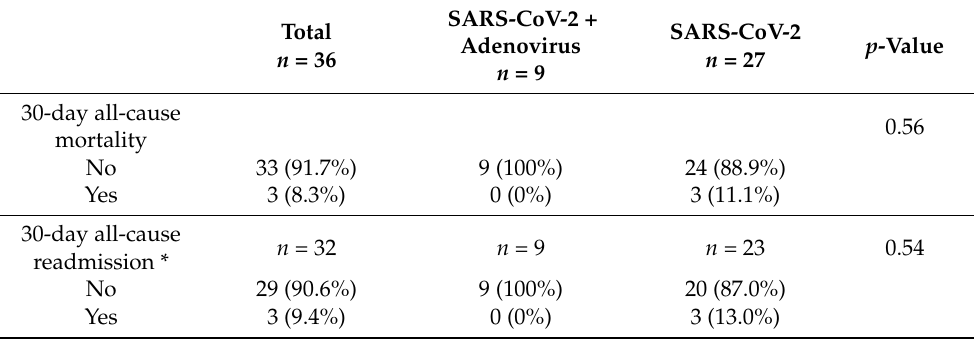
Table 6. Clinical outcomes between adults with SARS-CoV-2 + adenovirus infection or SARS-CoV-2